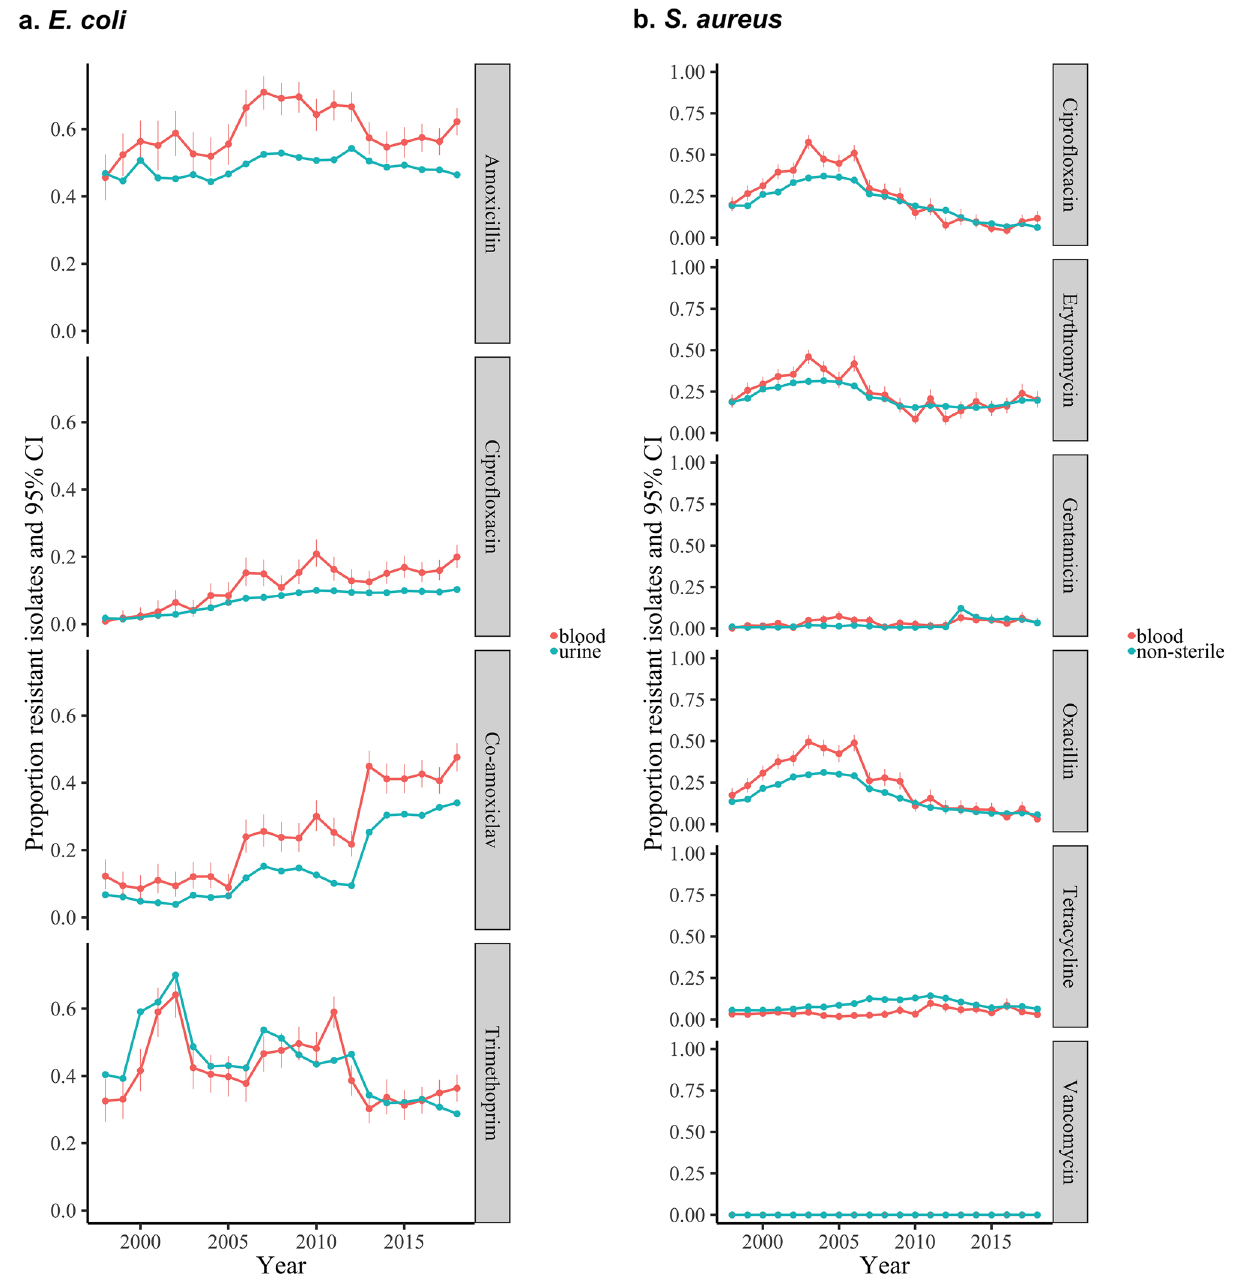
Figure 1. Resistance prevalence in E. coli and S. aureus in blood versus non-blood cultures in Oxfordshire, UK, 1998–2018 maximum cross-correlation at time lag 0 in 3/4 drugs (ciprofloxacin, co-amoxiclav, trimethoprim) for E. coli and 4/6 drugs for S. aureus (ciprofloxacin, erythromycin, gentamicin, oxacillin); cross-correlation 0.77 at lag 1 (0.75 at lag 0), 0.95 at lag 0, 0.96 at lag 0, 0.80 at lag 0 for E. coli and 0.95 at lag 0, 0.93 at lag 0, 0.54 at lag 0, 0.75 at lag 0, 0.69 at lag − 4, 0.60 at lag 3 for S. aureus from top to bottom respectively (full results in Supplementary Table time for S. aureus , reflecting generally higher rates of resistance in blood compared with non-sterile site cultures during the MRSA epidemic in the mid-2000s, which subsequently became more similar (Supplementary Fig. S3). For S. aureus , including nine other antibiotics (amoxicillin, clindamycin, co-trimoxazole, daptomycin, fusidic acid, linezolid, moxifloxacin, mupirocin, teicoplanin) tested between 2013 and 2018 only, resistance prevalences in blood and non-sterile site cultures were within 10% of each other in 167/180 (93%) drug-years, with 132 (73%) drug-years in the same resistance category and 45 (25%) in adjacent categories (Fig. 2, Table 1). Overall resist- ance prevalence in blood was highly correlated with resistance prevalence in non-sterile isolates [CCC = 0.97 (0.95–0.97)] (Table 1).